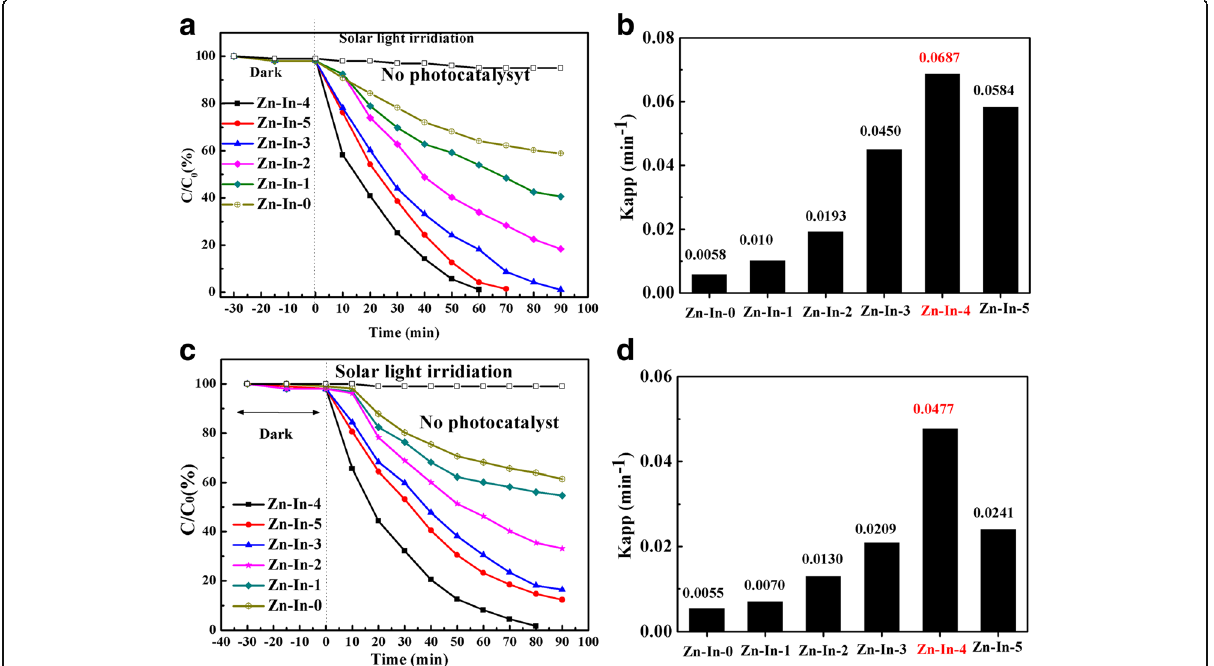
Fig. 7 Photocatalytic degradation curves and Kinetic linear simulation rate constants of MO ( a , b ) and 4-NP ( c , d ) by Zn-In-0, Zn-In-1, Zn-In-2, Zn- In-3, Zn-In-4,